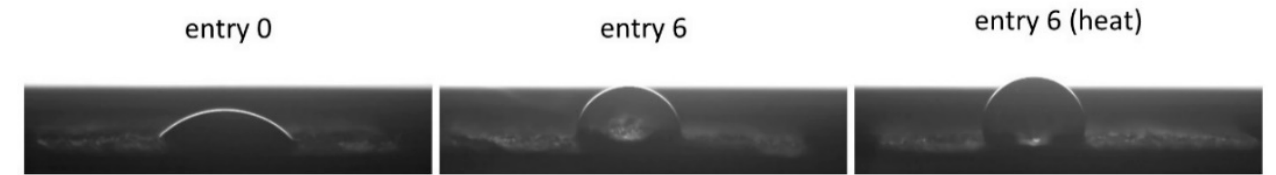
Figure 8. Contact angles for water droplets after 11 s on degreased wood (entry 0), benzylated wood (entry 6), and heat-treated benzylated wood (entry 6 (heat)) surfaces.